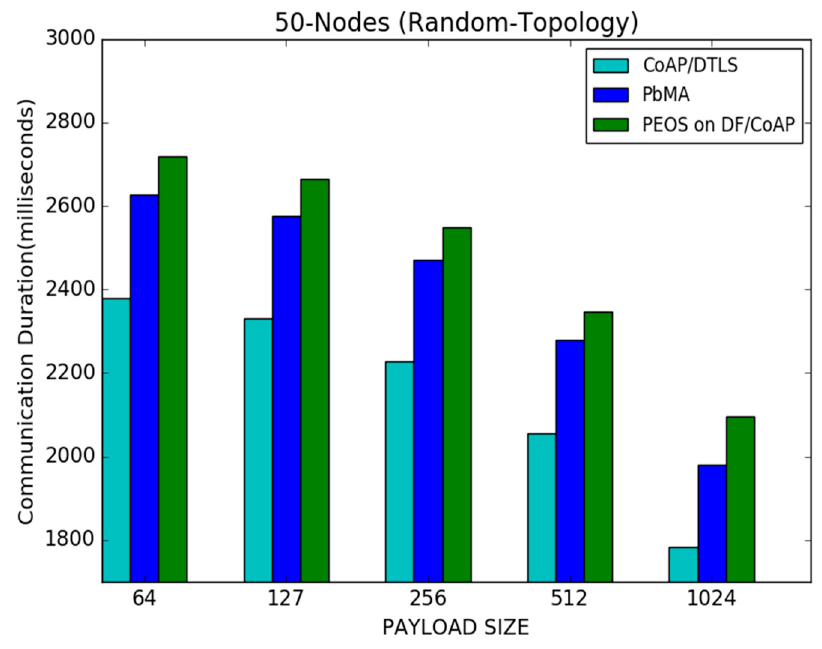
Figure 13. Payload size vs. communication duration for 50 node topology.